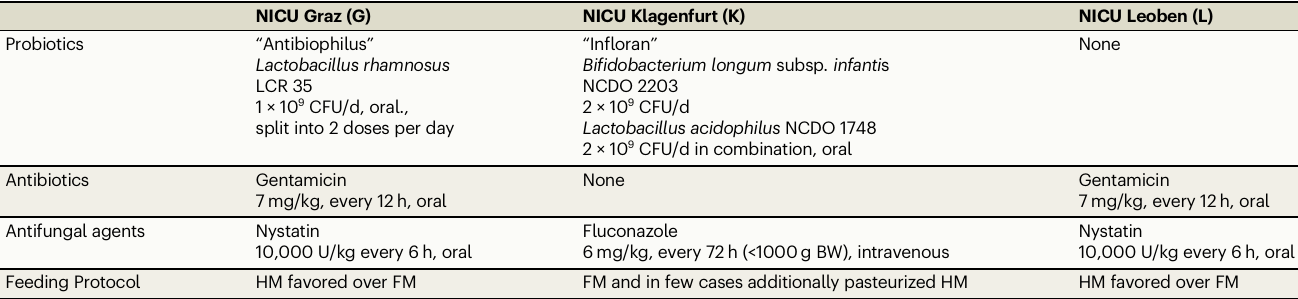
Feeding Protocol HM favored over FM FM and in few cases additionally pasteurized HM CFU Colony forming units, HM Human milk, FM